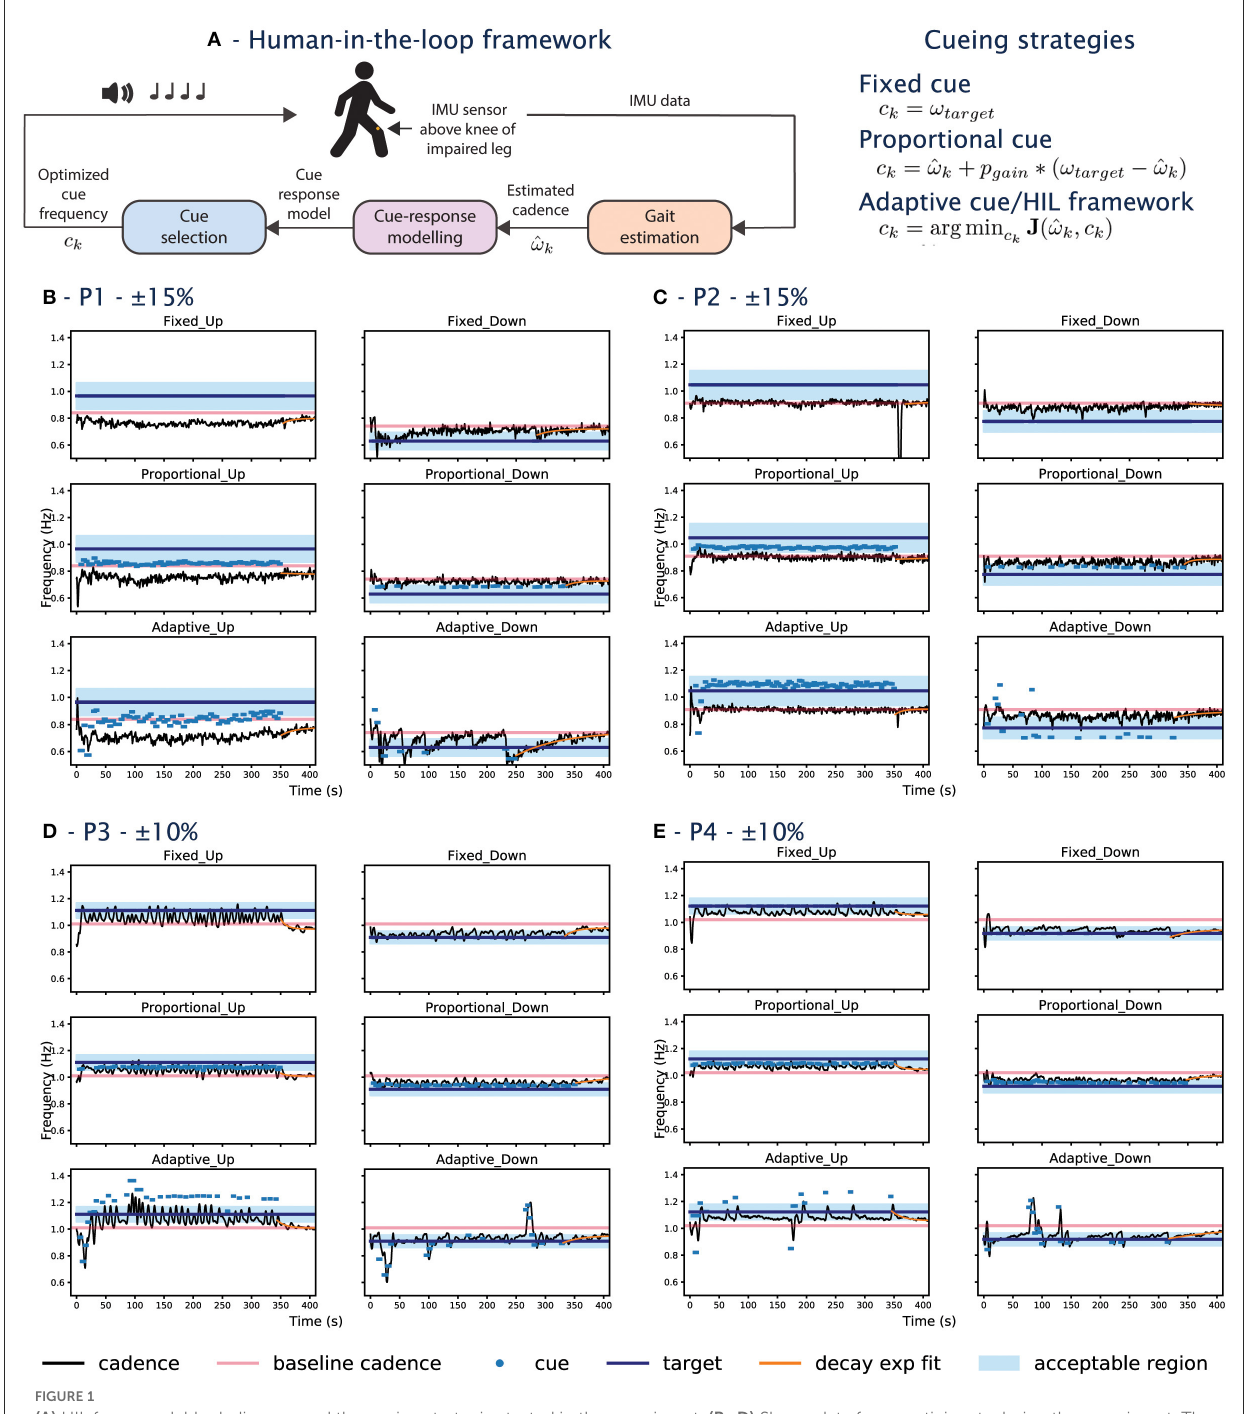
FIGURE1 (A) HIL framework block diagram and the cueing strategies tested in the experiment. (B–D) Shows data from participants during the experiment. The x-axis shows the time in seconds and the y-axis is the frequency. (B) Corresponds to P1, (C) for P2, (D) for P3, (E) for P4. For each participant, the left column shows the UP conditions, and the right column are the DOWN conditions. The first row shows the fixed conditions, the second row the proportional conditions, and the third row are the adaptive conditions. The goal of the cueing approach is to bring the person’s cadence (black line) into the blue-shaded acceptable region. The pink line shows the participant’s baseline cadence. The dots show the frequency of the cues when they are played. The target cadence is listed at the top for each participant.